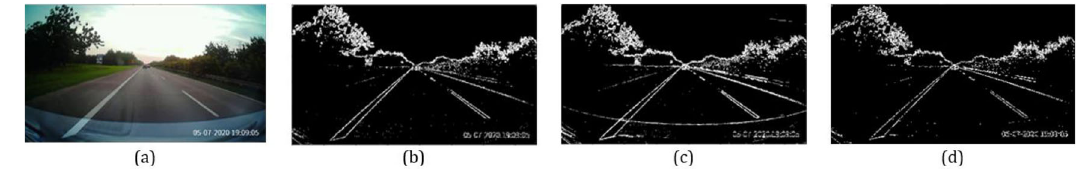
Figure 2. (a) Original image, (b), (c) and (d) Threshold results for M h , M v and k M k